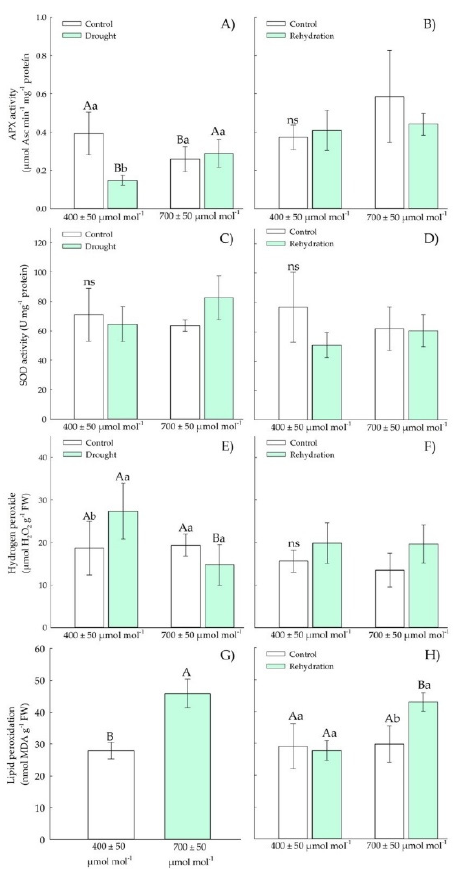
Figure 9. Effects of CO 2 concentration ( a [CO 2 ] = 400 µ mol mol − 1 and e [CO 2 ] = 700 µ mol mol − 1 ) and drought stress in A. buniifolius leaf APX activity ( A , B ), SOD activity ( C , D ), hydrogen peroxide ( E , F ), lipid peroxidation ( G , H ). In plants sampled drought stress ( A , C , E , G ) and rehydration ( B , D , F , H ) period. Different uppercase letters indicate a significant difference between values in different CO 2 within the same water treatment, while different lowercase letters indicate significant differences between values of different water treatments within each CO 2 level by Tukey’s test ( p ≤ 0.05). ns denotes non-significance ( p > 0.05). Error bars represent a 95% confidence